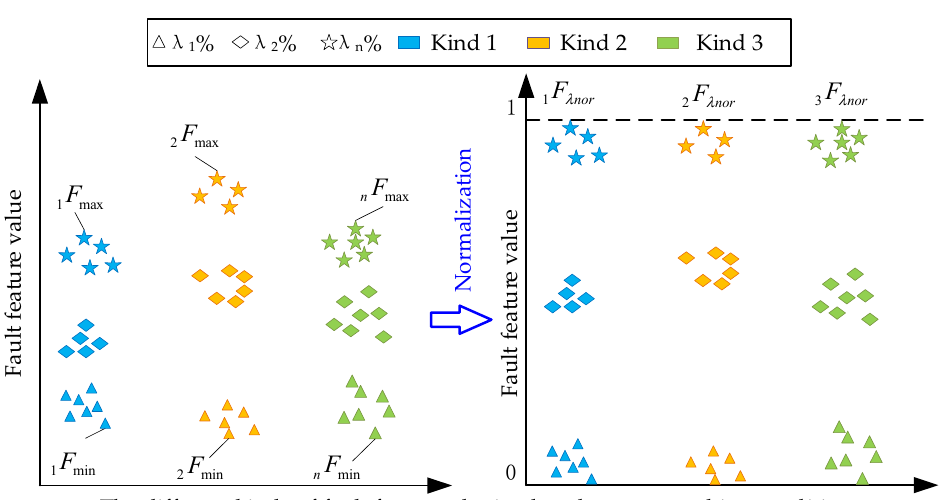
Figure 5. The schematic diagram of RCQFFV.